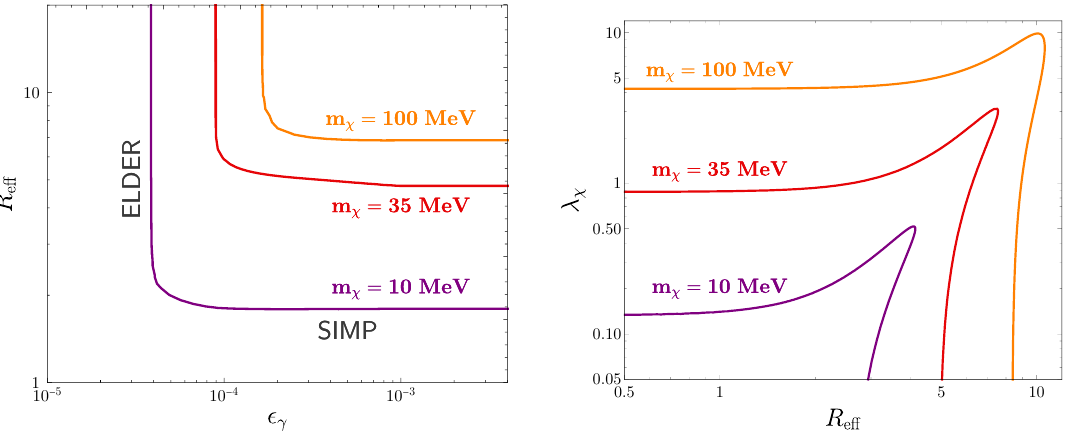
Figure 6 . Left: regions of CL model parameter space with (cid:31) relic density consistent with the current best-(cid:12)t (cid:3)CDM value. Right: constraints from galaxy cluster observations (the regions below the curves are allowed). In both plots, m S =m (cid:31) = 3 : 1, m V =m (cid:31) = 10, and g D = 1. In the right panel, we (cid:12)x R 1 = 10 for illustration.